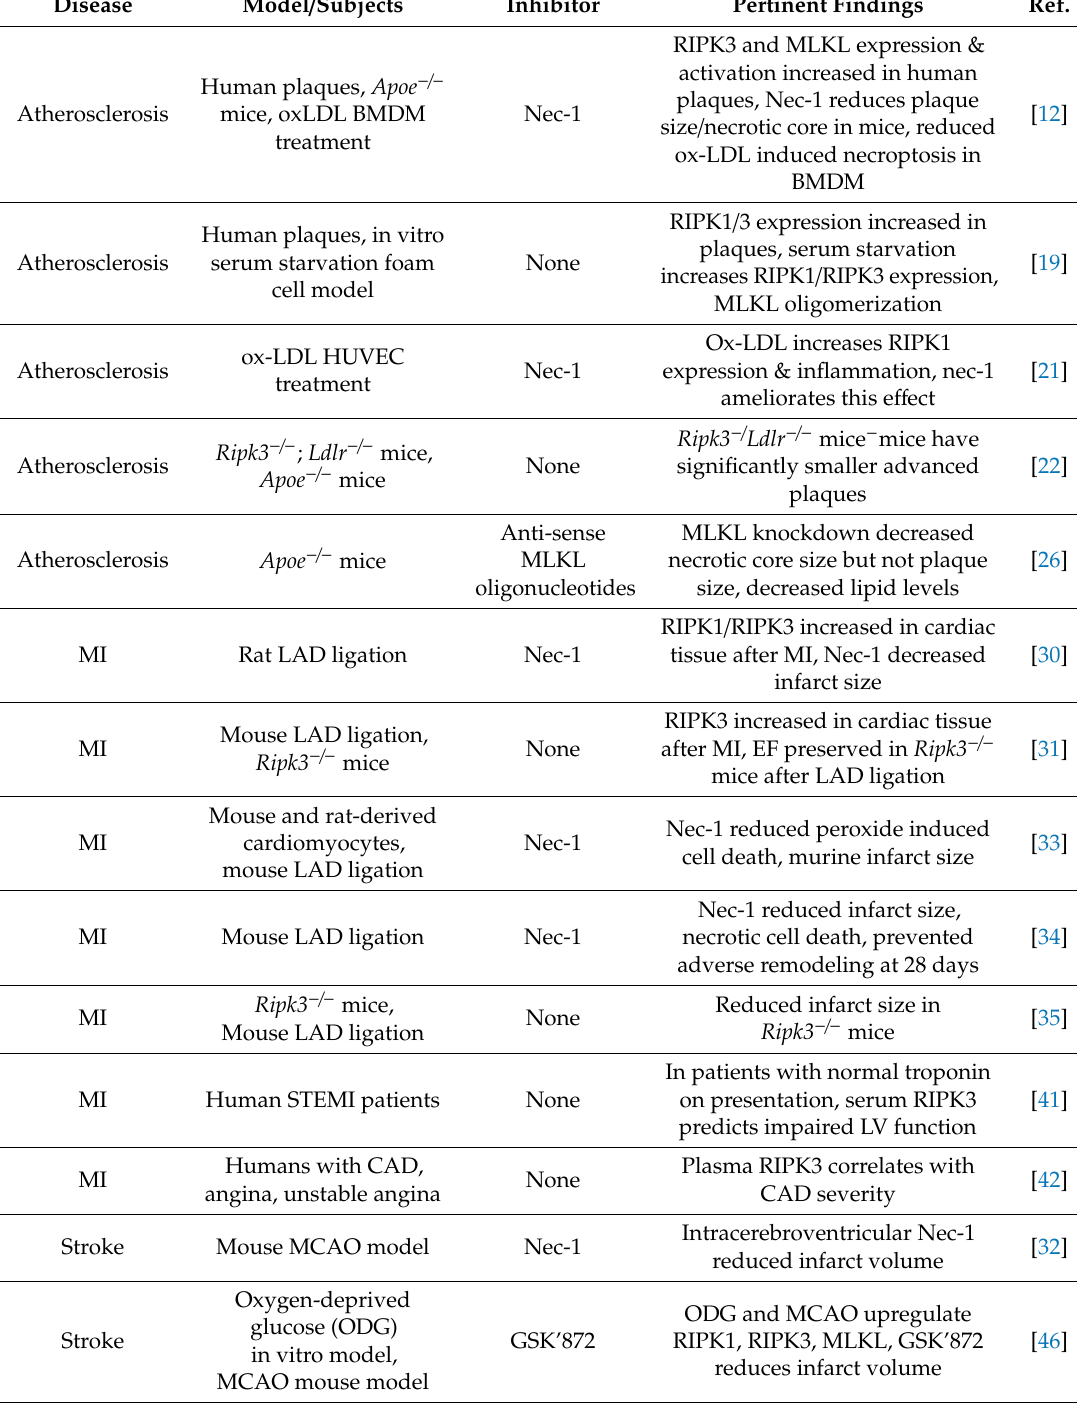
Table 1. Summary of Studies Investigating Receptor Interacting Protein Kinases in Cardiovascular